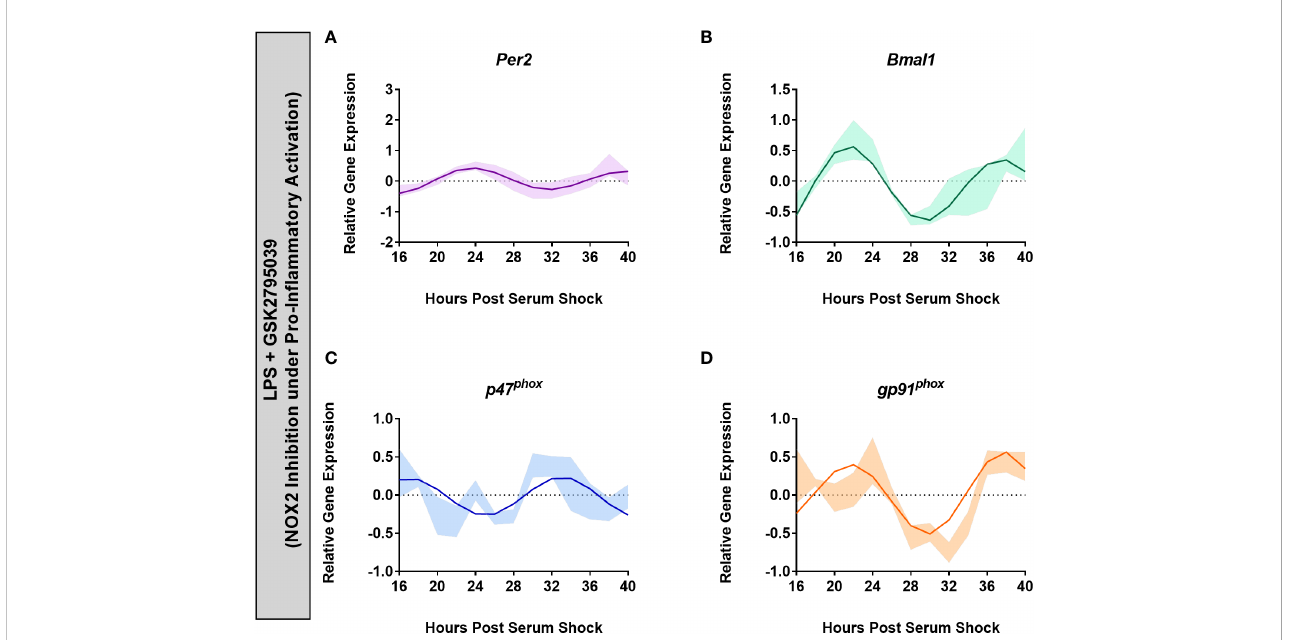
FIGURE 5 Inhibition of NOX2 by GSK2795039 under LPS activation results in the retention of circadian oscillations in BV2 microglia. ECHO fi tted plots for mRNA expression of clock genes (n = 3) (A) Per2 and (B) Bmal1 , and NOX2 components (C) gp91 phox and (D) p47 phox in BV2 microglia in the presence of 1 m g/ mL LPS and 25 m M GSK2795039. Data represented as fold change in expression using Hprt1 as a reference gene and HSP0 as a reference sample for the DD Ct method of data analysis. Bold line represent model fi t with shaded region representing the standard deviation of model at each time point. All plots had p<0.05 for ECHO signi fi cance fi